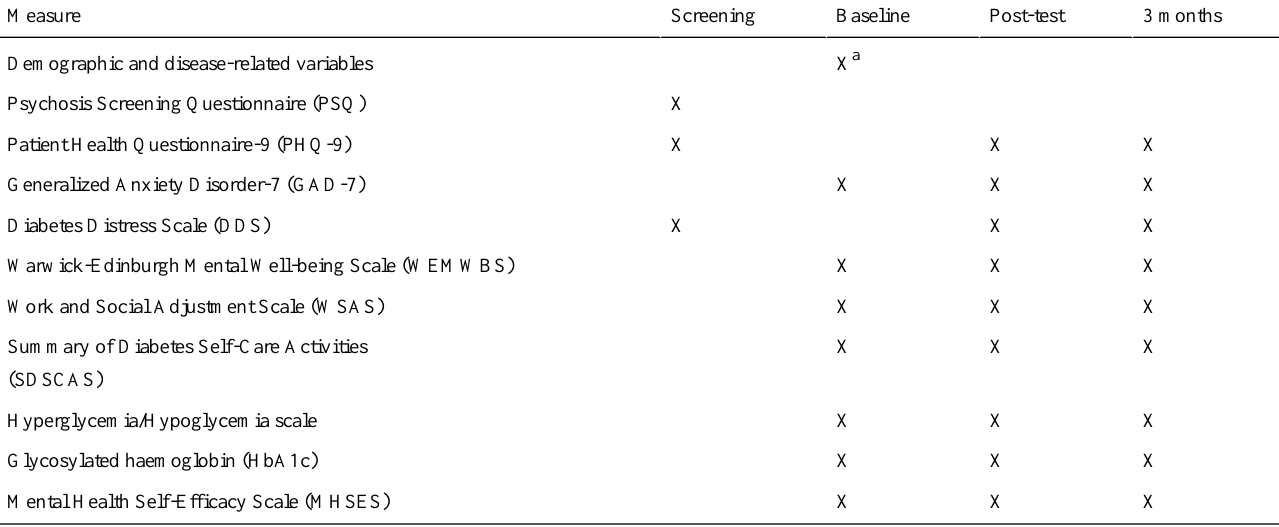
3 monthsPost-testBaselineScreeningMeasure